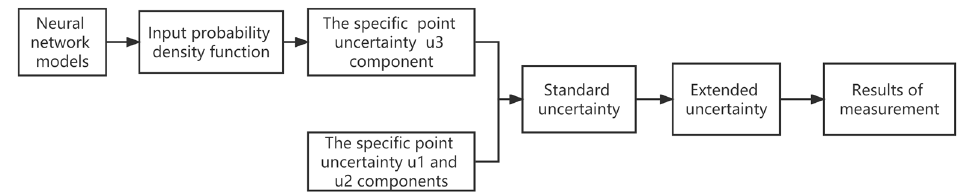
Figure 10. Flow chart of uncertainty assessment.